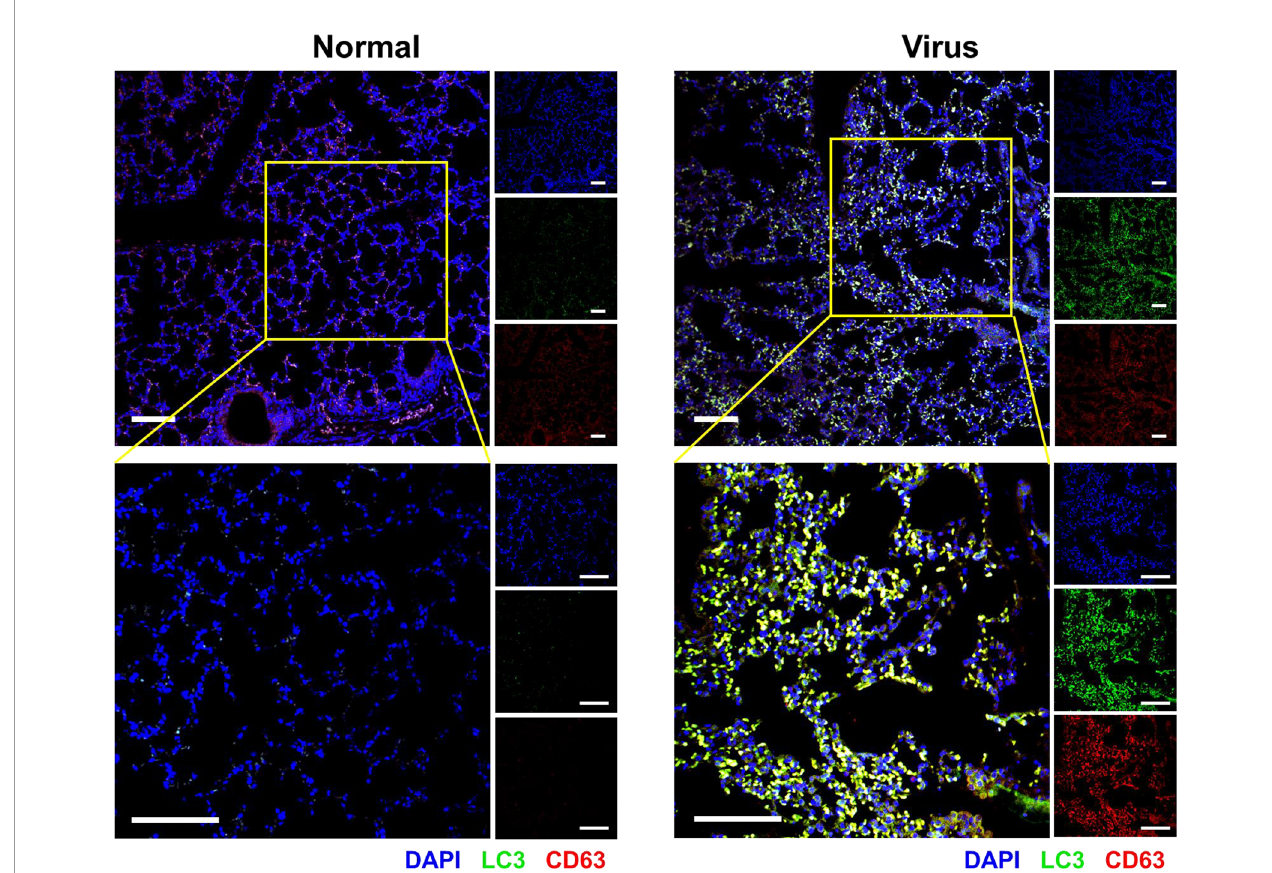
FIGURE 4 | Autophagy and exosomes in the infected lung tissues. Immuno fl uorescence histochemical staining of the lung tissue to determine the expression of LC3 (green) and CD63 (red) and their colocalization (yellow). The nuclei were stained with DAPI (blue). Scale bar: 100 m